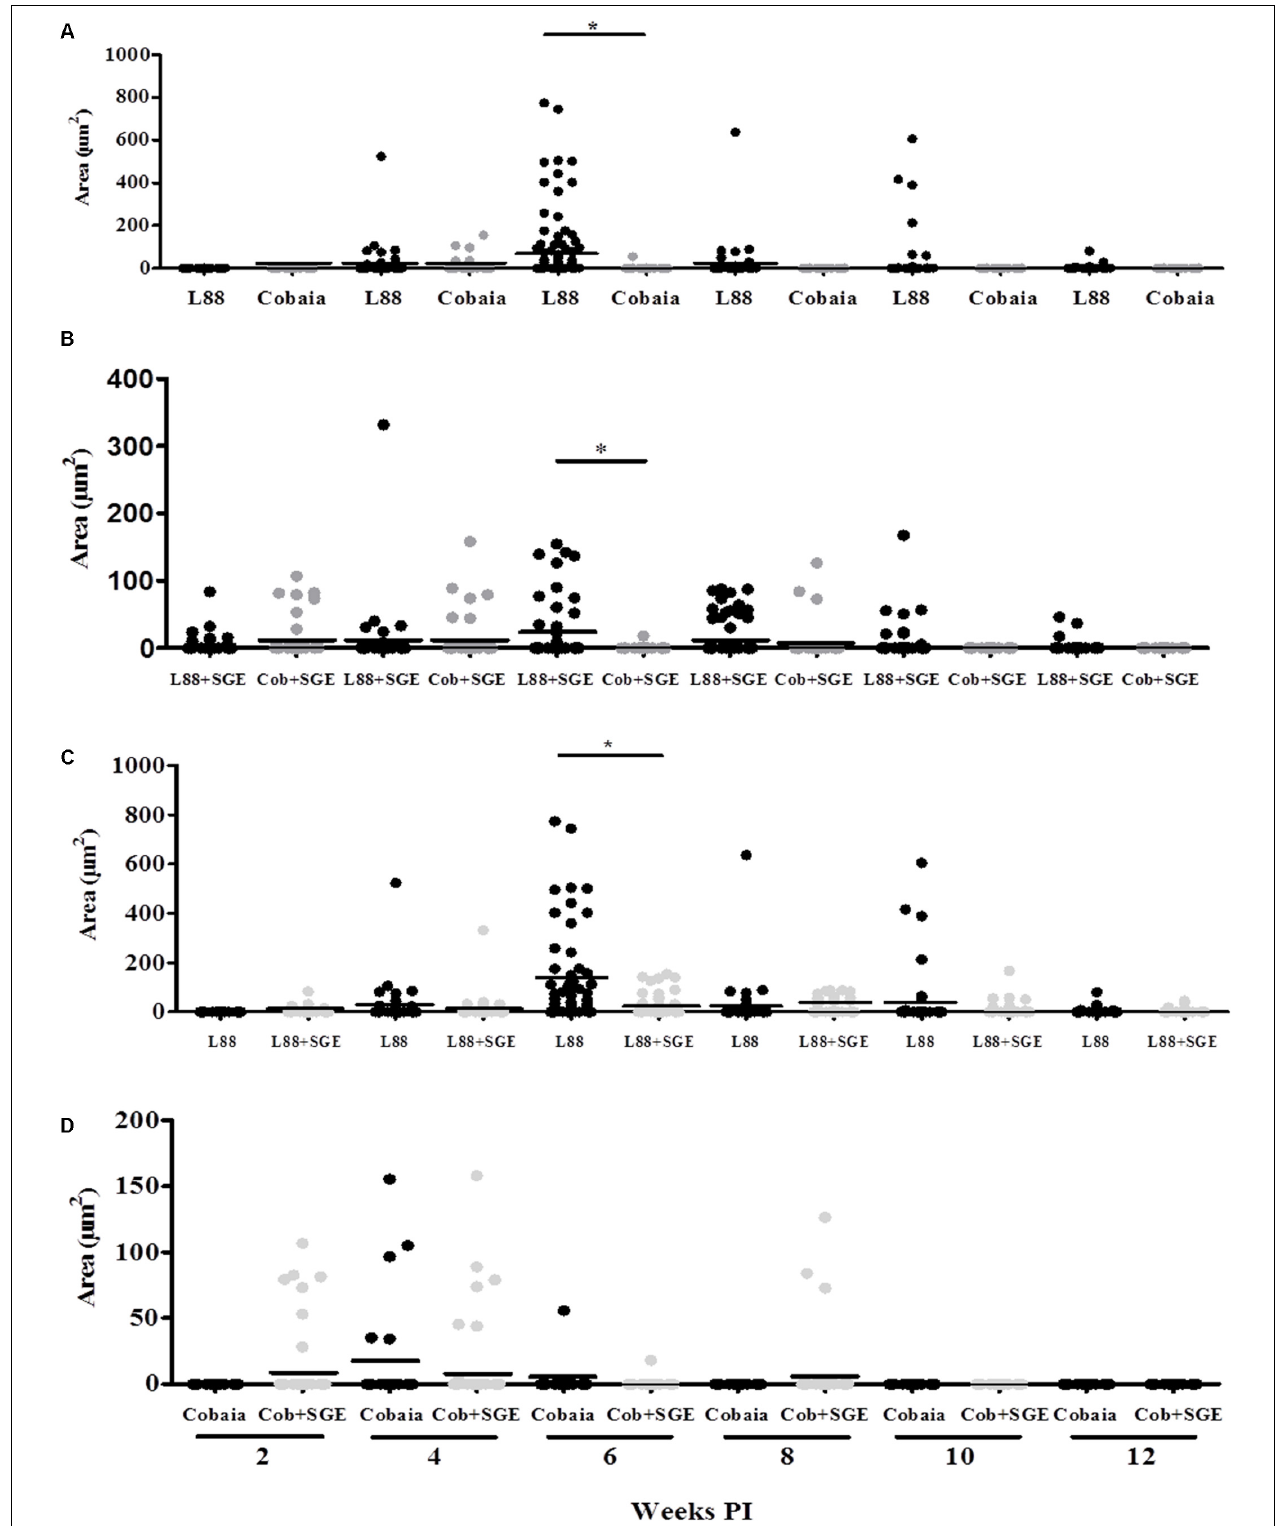
FIGURE 5 | Morphometric analysis ( µ m 2 ) of the immunohistochemistry (IHC) of C. porcellus infected with L. enriettii (L88 and Cobaia) strains in the absence/presence of salivary gland extract (SGE). Areas of amastigote staining in L88 versus Cobaia strains in the absence (A) or presence (B) of SGE. L88 (C) and Cobaia (D) strains in the absence/presence of SGE at 2, 4, 6, 8, 10 and 12 weeks PI. Asterisks indicate statistical significance between groups at p < 0.05.